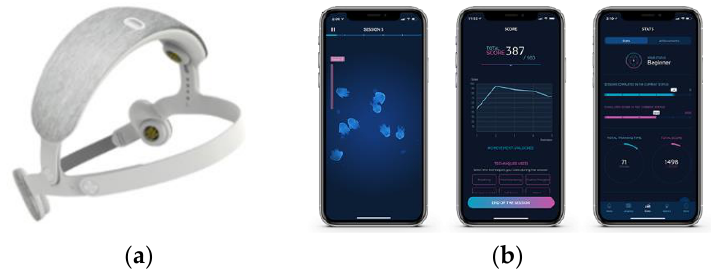
Figure 3. The URGOnight tele-neurofeedback device. The EEG headband ( a ) permits the recording of sensory-motor cortex electrical activity through four dry electrodes. Two of them are on the C3 and C4 positions, and the others are for reference (ground) and are placed on the mastoids. The mobile application ( b ) displays and emits visual and audio feedback according to the EEG fluctuations, and the app guides the neurofeedback training.